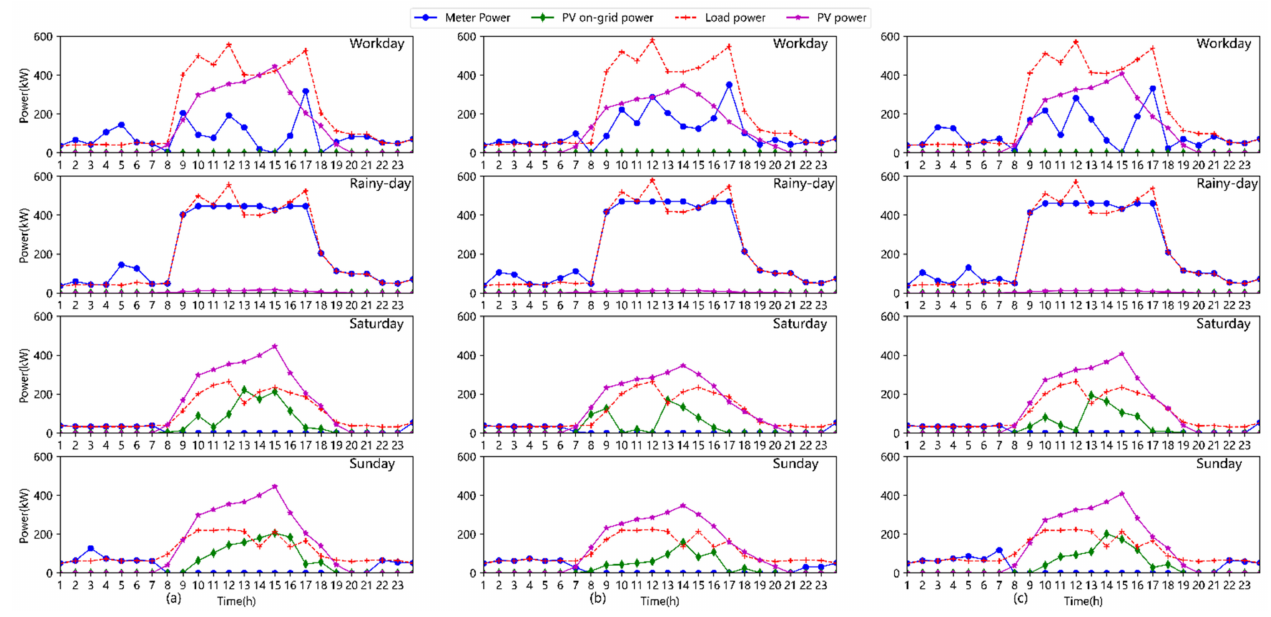
Figure 8. Power curves of gateway meter during typical days of different months. ( a ) March; ( b ) July; ( c ) November.